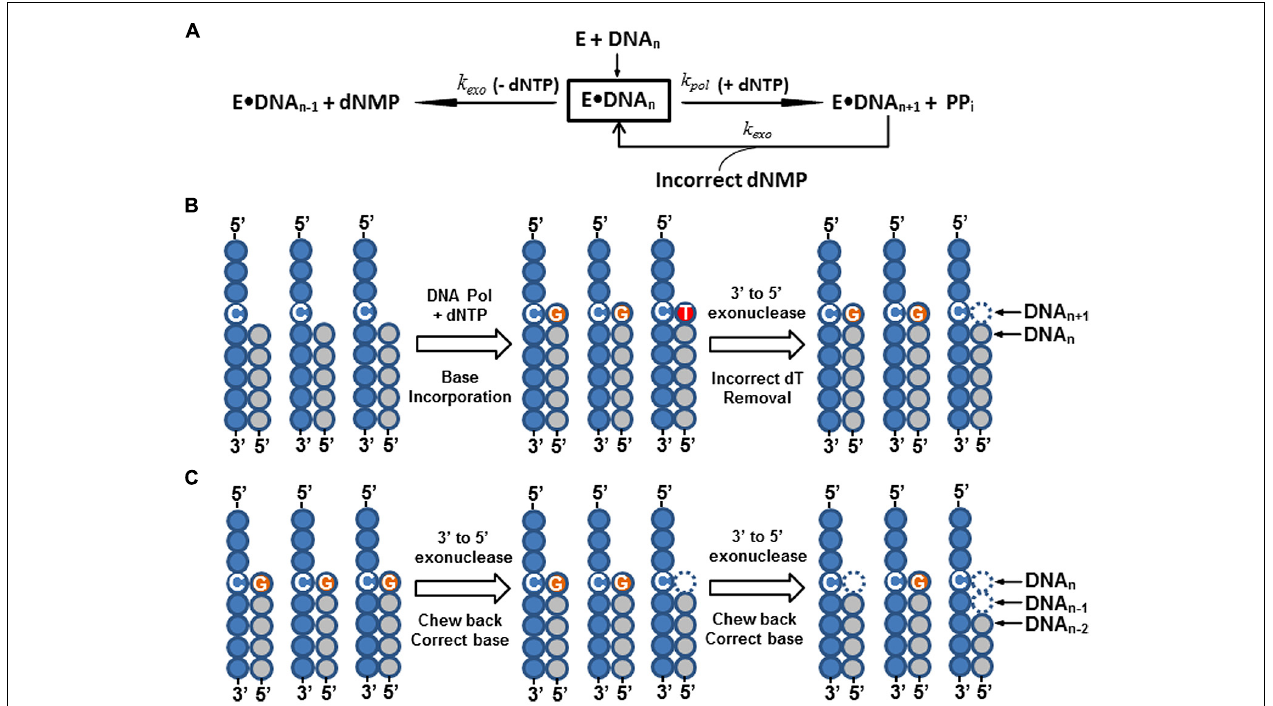
FIGURE 3 | Intrinsic 3 (cid:2) to 5 (cid:2) exonuclease activity of DNA polymerase and its impact on DNA sequencing reactions. (A) A simplified kinetic model illustrating the proofreading function and nucleotide excision activity of 3 (cid:2) to 5 (cid:2) exonuclease of DNA polymerase (Donlin etal., 1991; Johnson, 1993). As shown in the figure, when a free DNA polymerase (E) is mixed with a duplex primer/template DNA complex (DNA n ), they form a stable, binary enzyme − DNA complex (E • DNA n ). In the presence of nucleotide ( + dNTP) and divalent cations (Mg 2 + , Mn 2 + , etc.), the enzyme rapidly incorporates ( k pol ) a single-nucleotide base to the primer terminus (DNA n + 1 ) and concurrently drives release of free pyrophosphate (PP i ). However, when an incorrect nucleotide is misincorporated by the enzyme, it causes a base-pair mismatch at the primer terminus (DNA n + 1 ; Panel B , middle cartoon, a dC:dT mismatch). This mismatched nucleotide base at the primer terminus greatly impedes the DNA polymerase’s capability to incorporate the next nucleotide base (greatly reduced k pol value) and triggers a rapid transfer of DNA primer strand to the intrinsic 3 (cid:2) to 5 (cid:2) exonuclease domain. The mismatched nucleotide base is then removed (incorrect deoxynucleoside monophosphate, dNMP) by the 3 (cid:2) to 5 (cid:2)